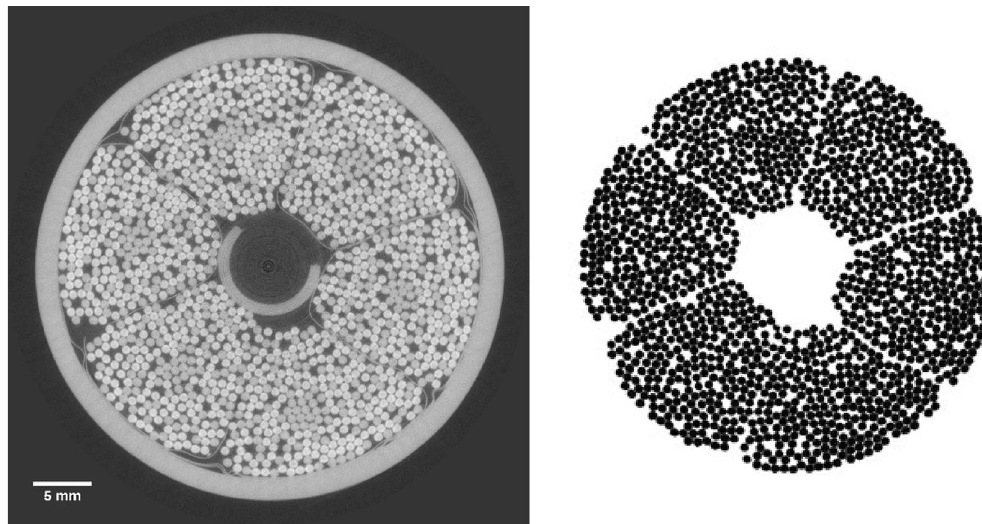
Figure 3. Thresholding and segmentation procedure of conductor. (Left) A reconstructed image slice of the conductor, prior to thresholding. (Right) A binarised image of the superconducting bundles, isolated from all other components.